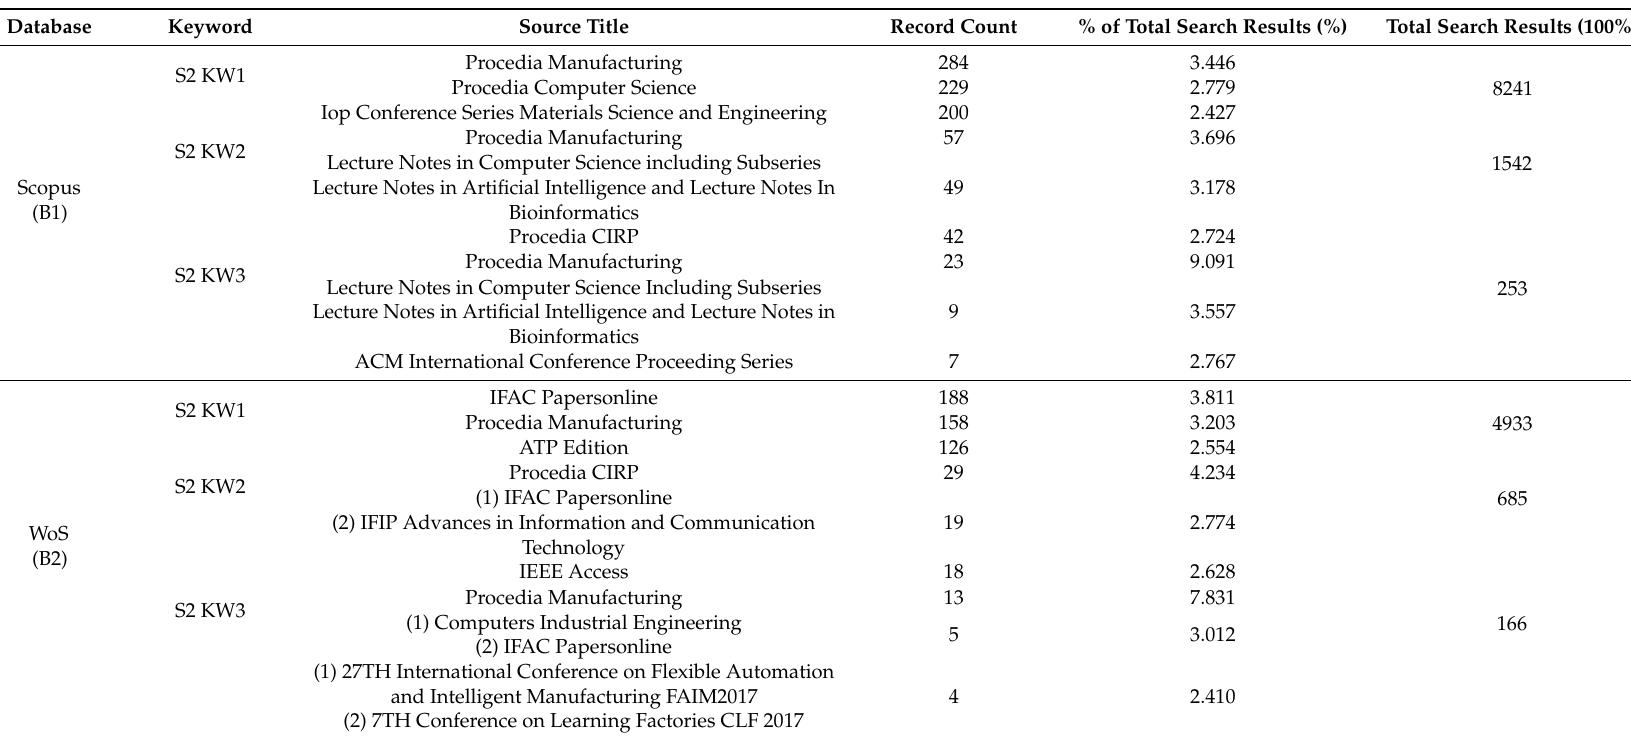
Table 7. Top 3 most important sources with the largest number of articles for the keywords: “Industry 4.0”, “smart factory” or “smart